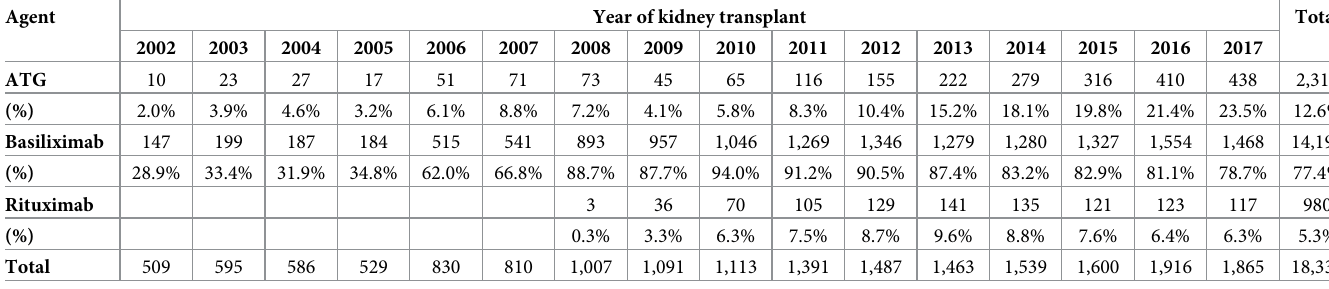
Table 2. Induction therapy and desensitization